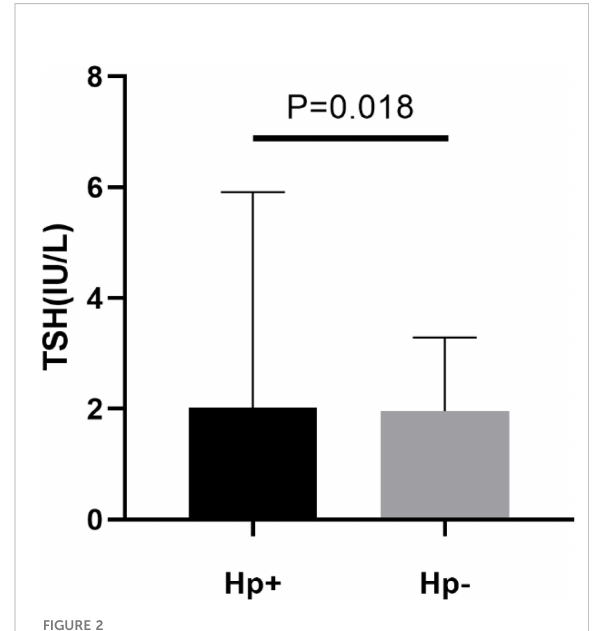
FIGURE 2 Levels of plasma thyroid stimulating hormone (TSH) in patients with H. pylori seropositive (Hp+) and H. pylori seronegative (Hp-).